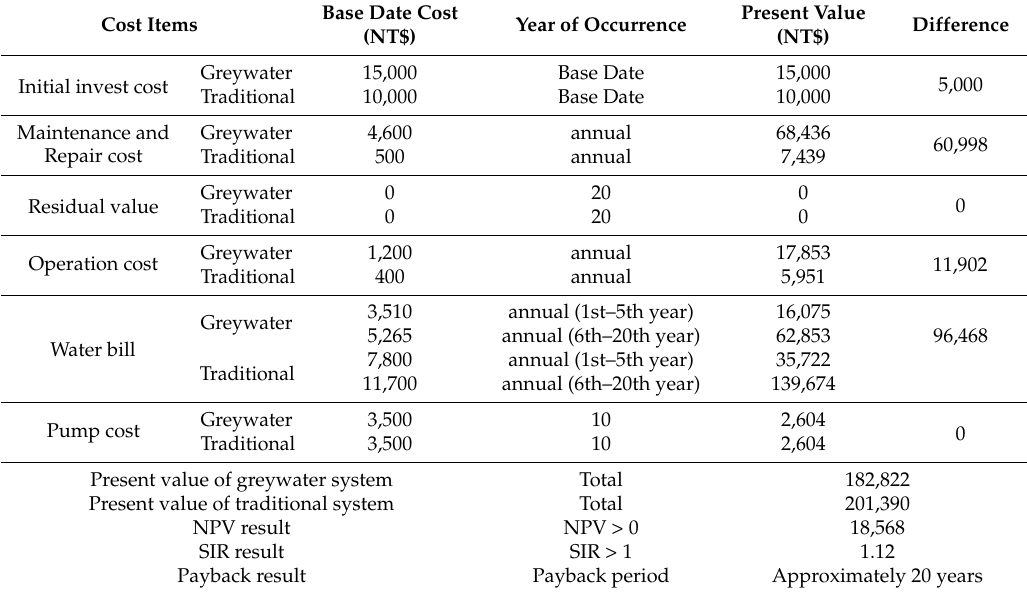
Table 3. Economic analysis of scenario